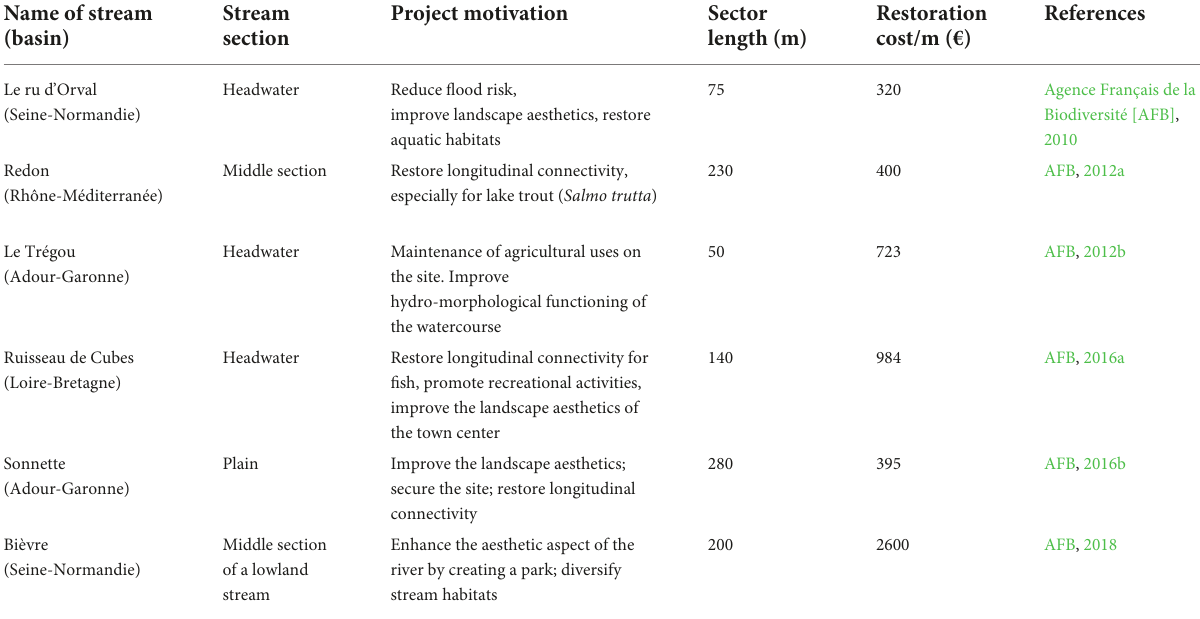
TABLE 3 Daylighting projects in France, registered by OFB (Eau et Biodiversité, 2021, see Supplementary Annex I for details). Name of stream (basin)